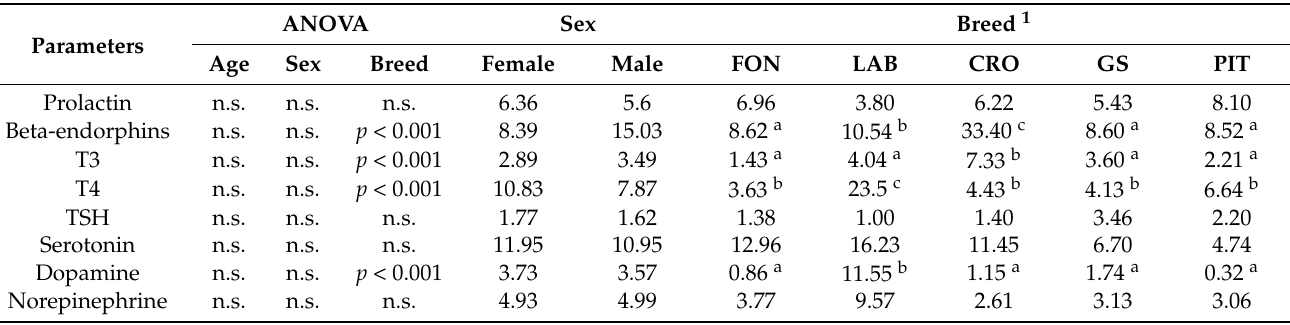
Table 3. Results of the linear model obtained for each parameter obtained from investigated dog